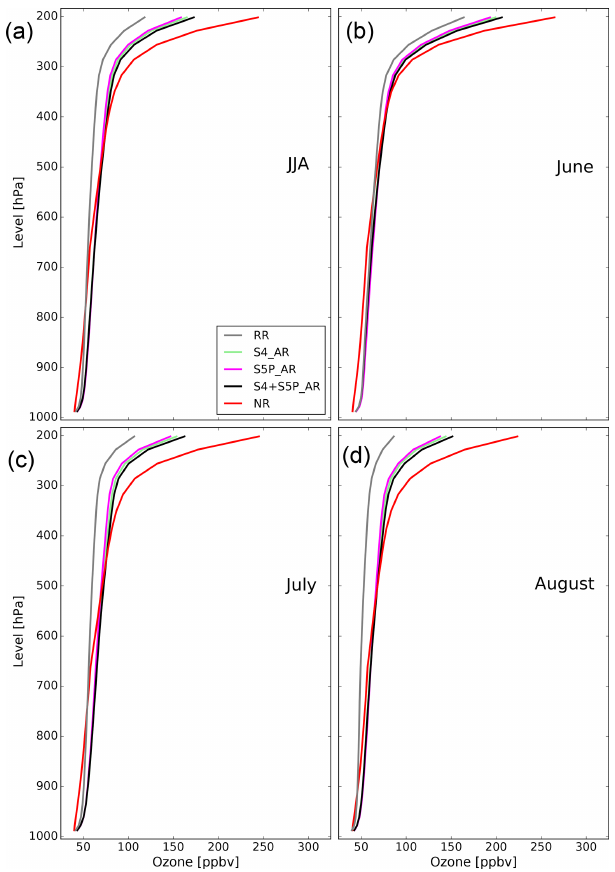
Figure 6. Ozone profiles (ppbv) averaged for summer 2003 (JJA) and June (a, b) , July, and August (c, d) over the European domain, as simulated from the reference run (grey lines), the S4_AR (green lines), the S5P_AR (magenta lines), the S4+S5P_AR (black lines), and the nature runs (red